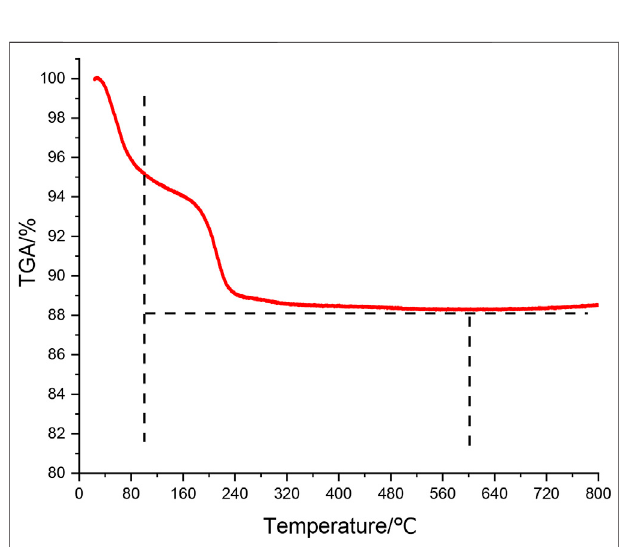
FIGURE 4 | TGA of 3D SiO 2 -NH-SO 3 H.